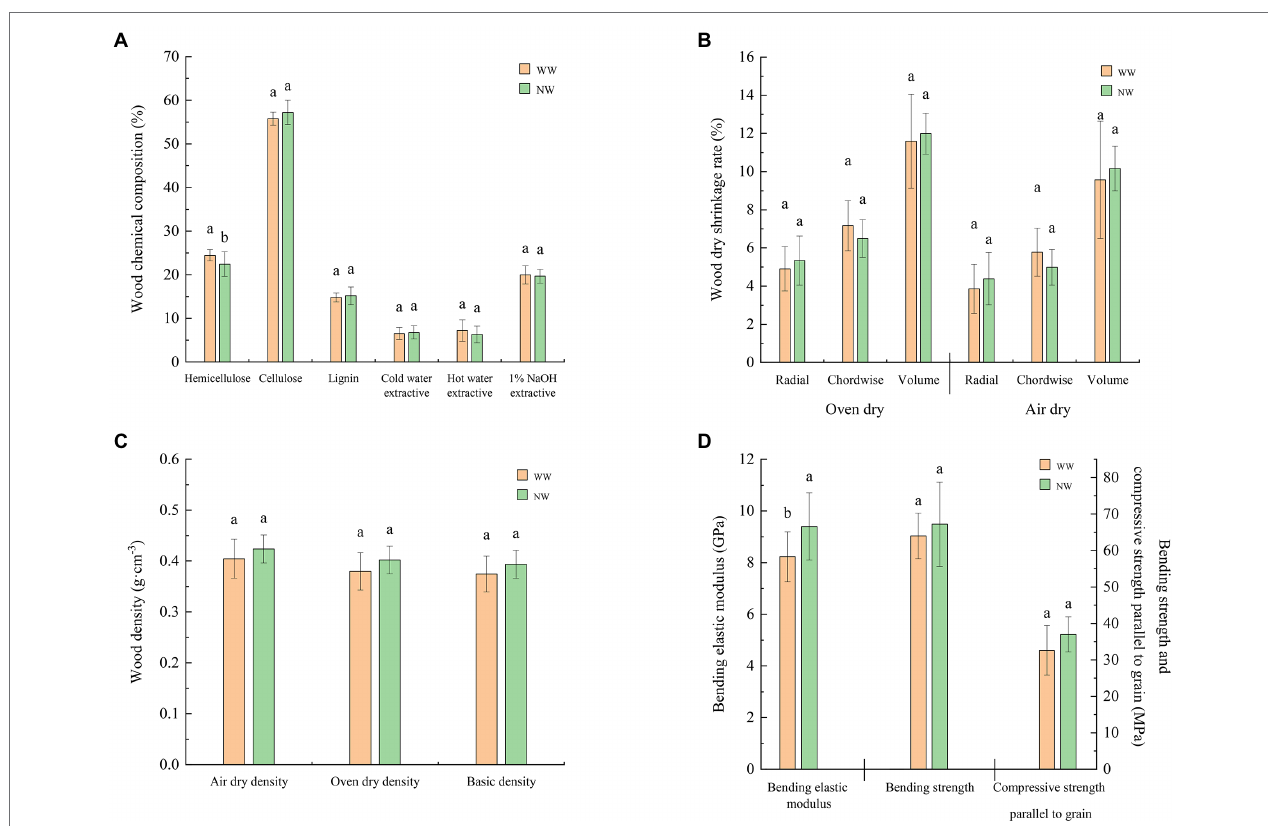
FIGURE 3 | Chemical properties and physical and mechanical indicators of the heartwood. (A) Chemical composition of the heartwood; (B) Dry shrinkage rate of the heartwood; (C) Density of the heartwood; and (D) Mechanical indicators of the heartwood. The letter represents a significant difference at the p < 0.05 level. WW and NW represent diseased and healthy trees,